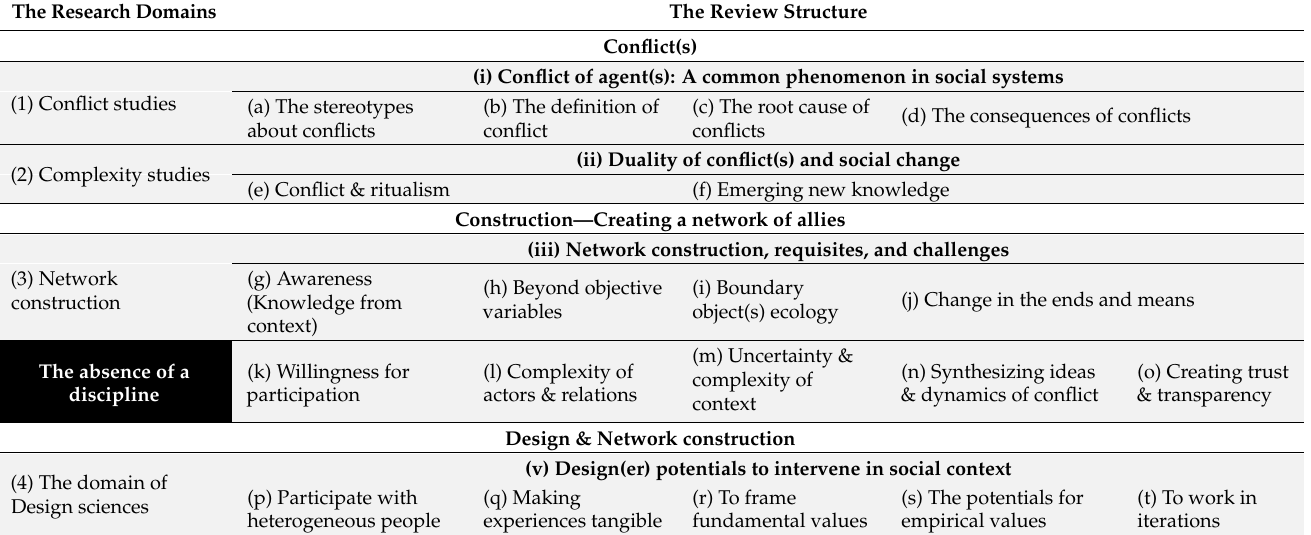
Table 1. The review